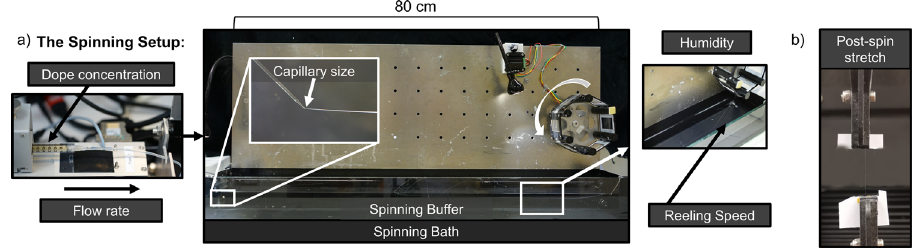
Fig. 1 A custom-made spinning setup for manufacturing biomimetic arti fi cial spider silk with the parameters investigated herein highlighted. a A highly concentrated aqueous solution (dope) of the minispidroin NT2RepCT is pumped from a syringe through polyethylene tubing and a glass capillary with a tapered tip into the spinning bath containing an aqueous buffer. At the end of the spinning bath, the fi bers are collected on a rotating wheel. Parameters investigated are: 1. Dope concentration (150 – 450 mg/mL); 2. Flow rate (10 – 35 µ L/min); 3. Capillary size (opening diameter 28 – 99 µ m); 4. Relative humidity (30 – 85%); 5. The reeling speed (9 – 69 cm/s); 6. Buffer strength, type, and pH (250 – 1000 mM acetate/succinate/citrate/citrate- phosphate buffer, pH 4 – 5). b The effect of post-spin stretching was investigated by stretching fi bers to de fi ned lengths using a tensile